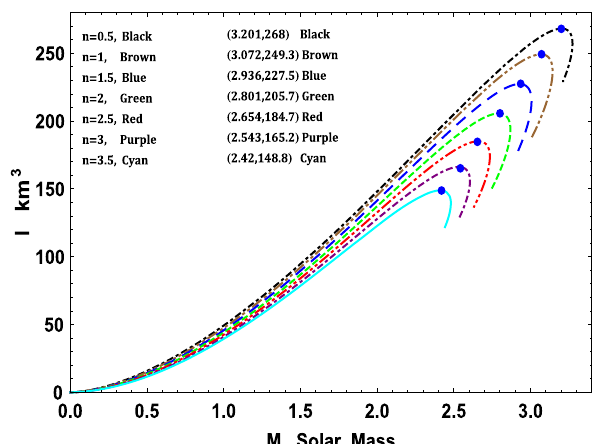
Fig. 7 M – I graphs for a = 0 . 001 km − 2 and β = 0 . 2